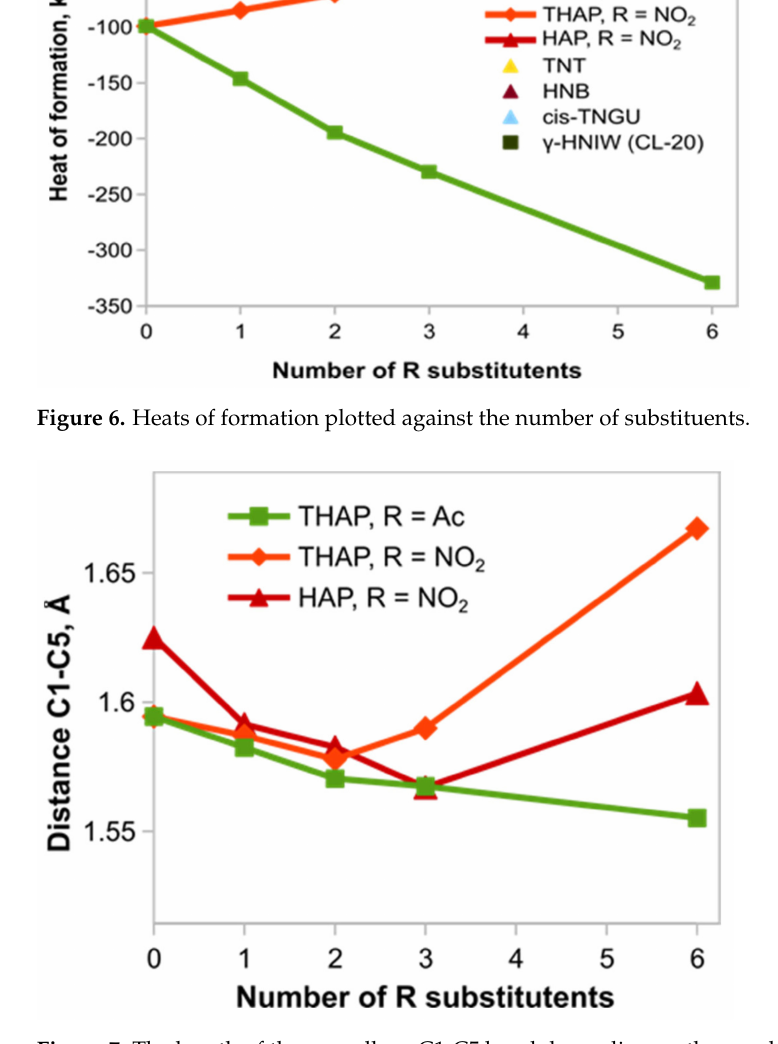
Figure 7. The length of the propellane C1-C5 bond depending on the number of substituents